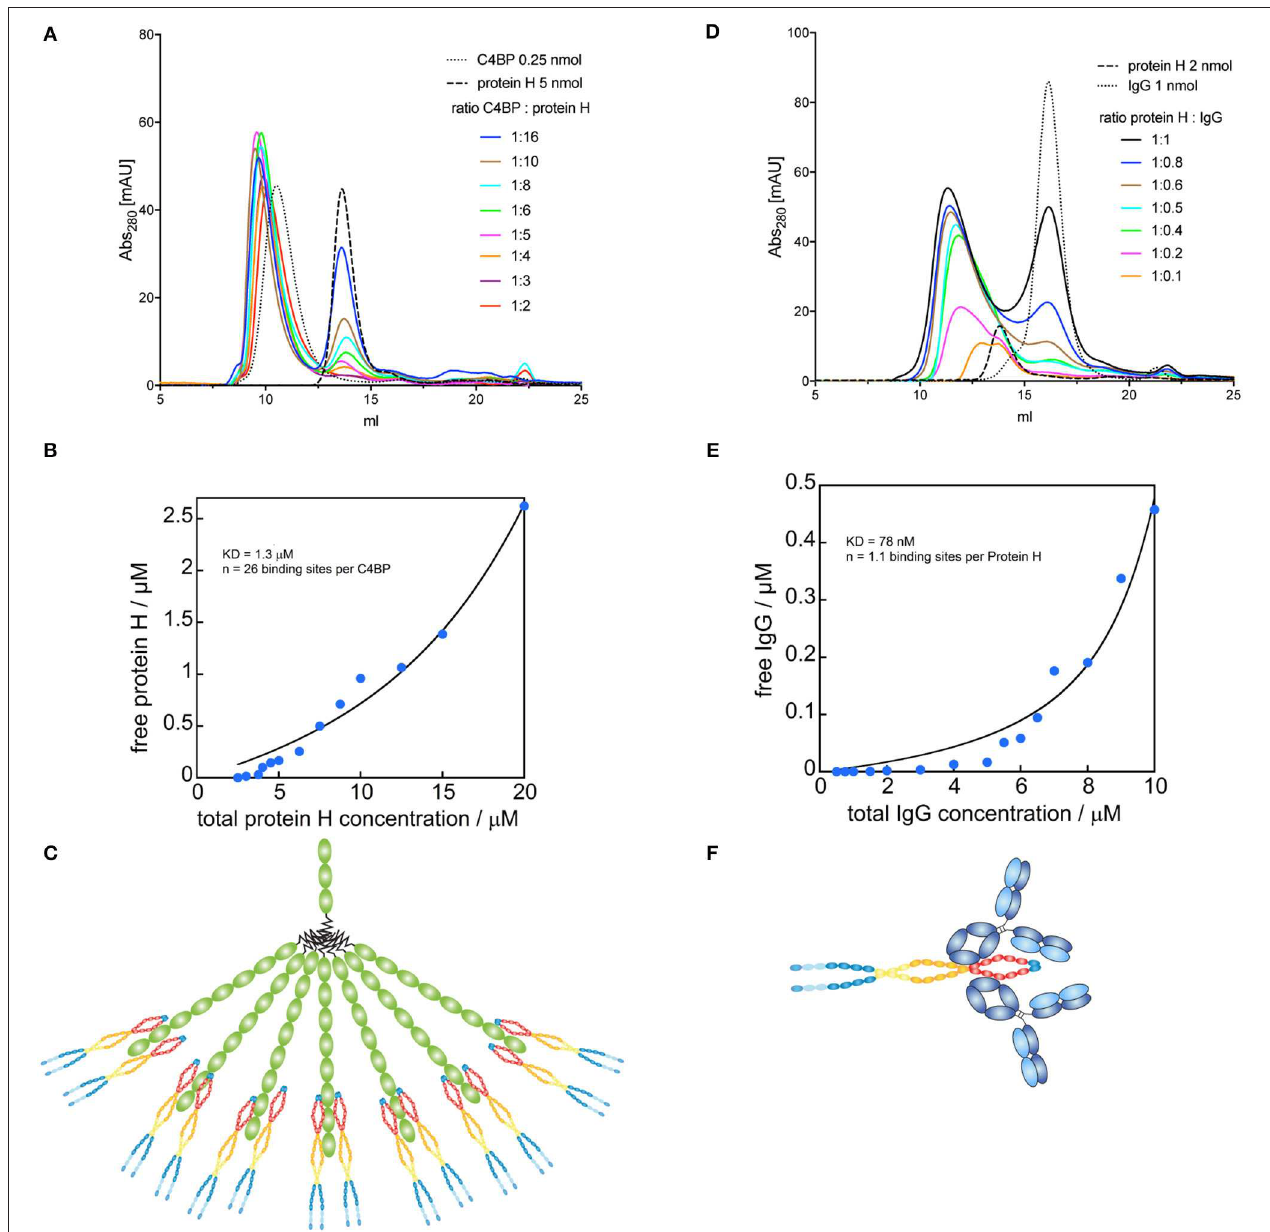
FIGURE 4 | Binding sites for Protein H on C4BP and IgG. C4BP-Protein H and Protein H-IgG interactions were analyzed in combination by SEC on a Superose 6 column. (A) C4BP-Protein H complexes were formed in PBS with 0.25 nmol C4BP and varying amounts of Protein H (indicated by molar ratio). (B) AUC of free Protein H (eluted at 13.74ml) was plotted against total Protein H concentration ( n 13). (C) Analysis revealed that one molecule of C4BP can bind up to 26 2 = ± Protein H monomers and is shown diagrammatically. (D) Protein H-IgG complexes were formed in PBS with 2 nmol Protein H and varying amounts of IgG (indicated by molar ratio). (E) AUC of free IgG (eluted at 16.19ml) was plotted against total IgG concentration ( n 15). (F) Analysis revealed that one Protein H dimer can bind = up to two IgG and is represented diagrammatically. In (B,D) blue dots represent individual measurements, black lines are corresponding fits. Every curve or data point represents an independent experiment. In (A,D) representative elution curves are displayed, while all experiments were used for the analysis in (B,E) .